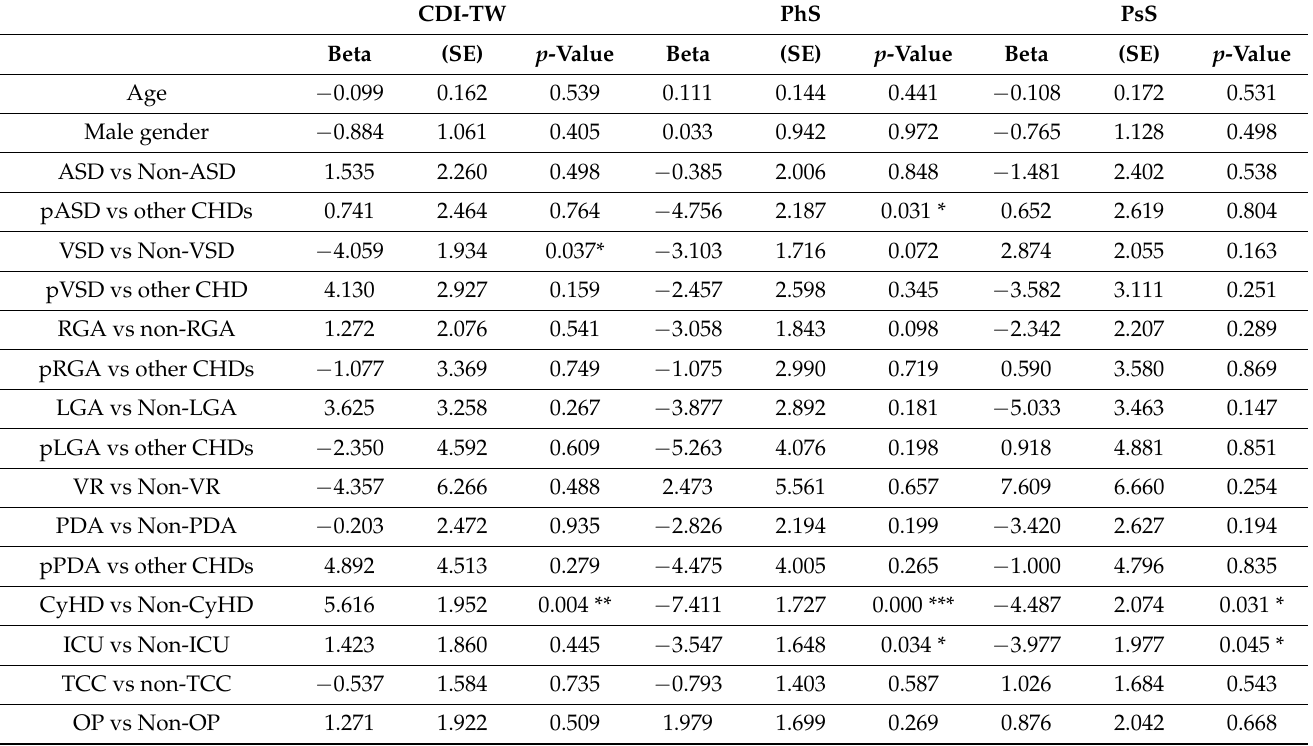
Table 4. Multivariant analysis for the relationships between multiple factors and Children Depression Inventory-TW total score, physical summary score, or psychosocial summary score in Child Health Questionnaire—Parent Form 50.